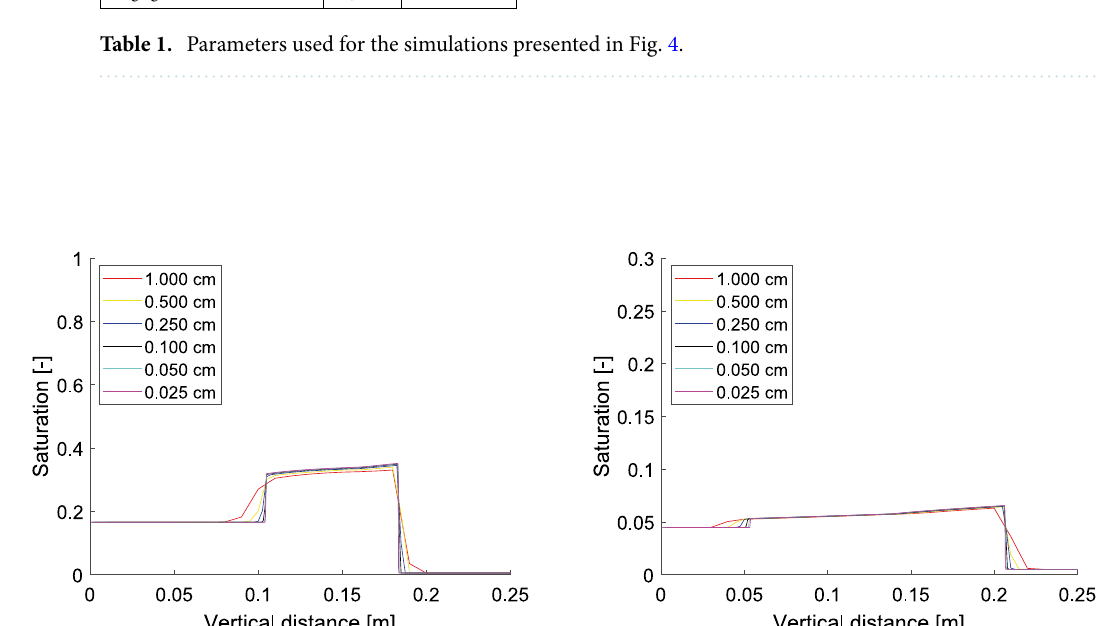
50 minutes for (cid:31) x 0 for initial saturation = → 6 m/s. The flux out of the bottom block 5 10 − = × 600 minutes for (cid:31) x 0 for = → 7 m/s. The flux out of 1 10 − = ×